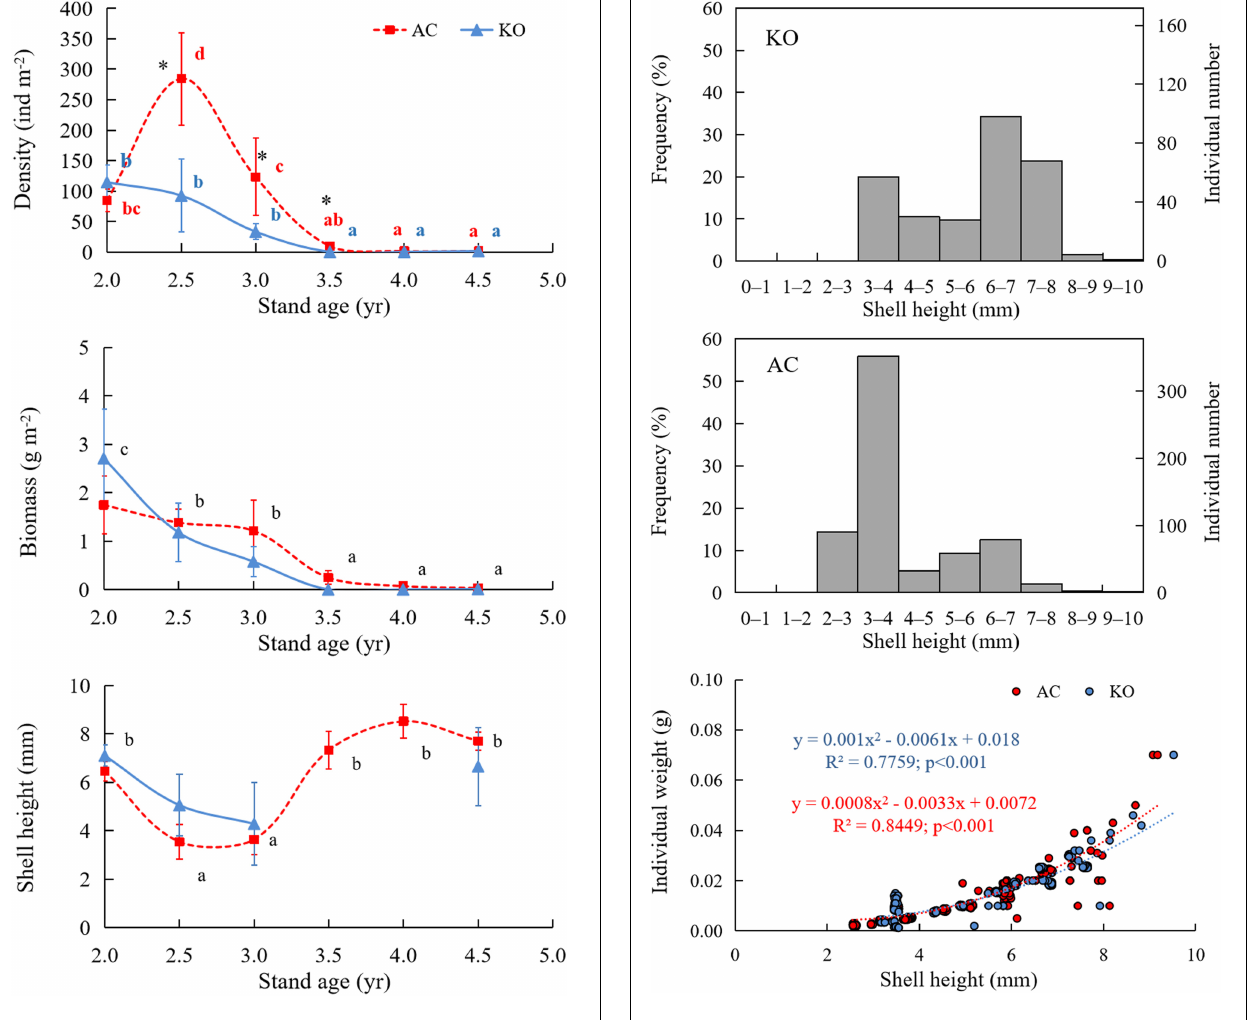
FIGURE 3 | Densities, biomasses, and shell heights of Mainwaringia leithii in the two mangrove sites. For biomasses and shell heights, different letters indicate significant differences among the stand ages at p < 0.05. For density, the asterisk ( ∗ ) symbol indicates significant differences between the two mangrove sites according to t -tests at p < 0.05, and different letters in red and blue indicate significant differences among the stand ages at p < 0.05 in AC and KO sites, respectively.